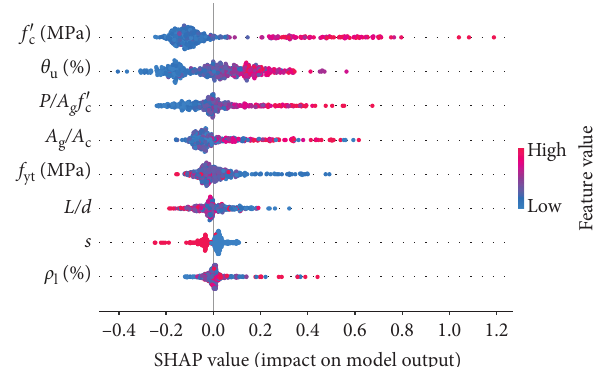
Figure 5: Global interpretation of the XGBoost